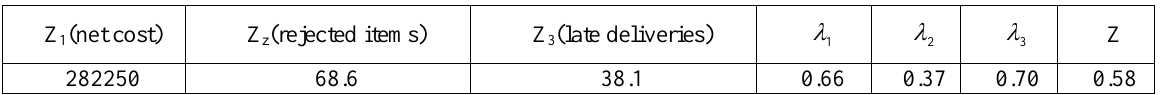
= 0.54, 𝑤 = 0.28, 𝑤 = 0.18 ). 1 2 2